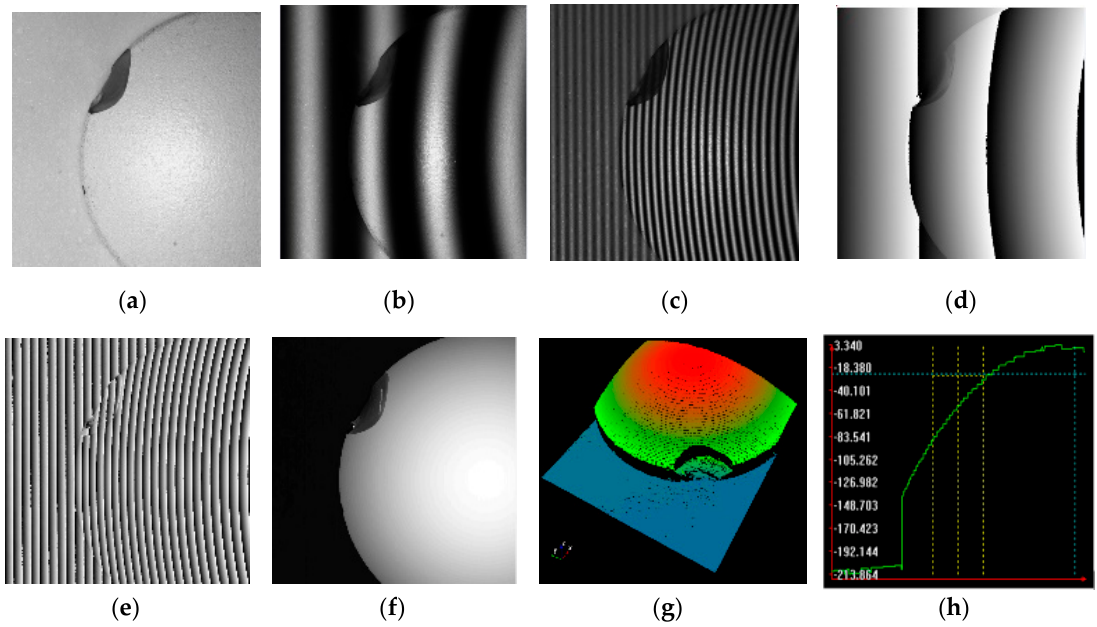
Figure 10. Captured image and its wrapped phase map with different projected patterns on semisphere target: ( a ) uniform light; ( b ) 121-pixel sinusoidal fringe pitch; ( c ) 12-pixel sinusoidal fringe pitch; ( d ) wrapped phase of ( b ); ( e ) wrapped phase of ( c ); ( f ) absolute height map calculated using proposed algorithm; ( g ) 3D profile; and ( h ) height cross-section of row 512 of ( f ).